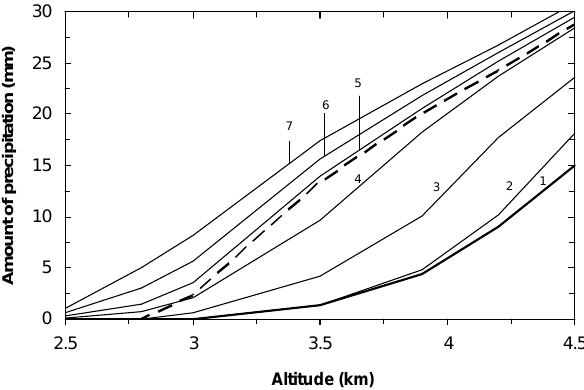
Figure 10. Simulated total amount of precipitations, defined as r>200 μ m, from clouds of 3 Fig. 10. Simulated total amount of precipitations, defined as r> 200µm, from clouds of different thicknesses without the intro- different thicknesses without the introduction of particles (1), with the 12 kg/km 2 particles of 4 duction of particles (1), with the 12kg/km 2 particles of the South the South African flares consumed (2), with 2.4, 6, 12, 24, 48 kg/km 2 of the salt powder 5 African flares consumed (2), with 2.4, 6, 12, 24, 48kg/km 2 of the (curves 3 – 7, respectively). Dashed lines refer to the introduction of 64 kg/km 2 of salt 6 salt powder (curves 3–7, respectively). Dashed lines refer to the in- particles with the radii of 1 µm. The precipitation is calculated at the level of cloud base. 7 troduction of 64kg/km 2 of salt particles with the radii of 1µm. The precipitation is calculated at the level of cloud